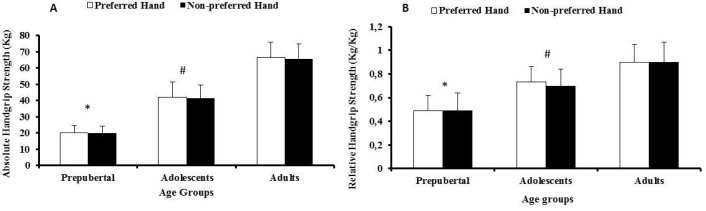
Absolute (A) and relative (B) handgrip strength values (kg; kg / kg BM, respectively) in children, adolescents, and adults basketball players. Values are means ± SD in each hand per age group; *p < 0.05 vs. all other groups; #p < 0.05 vs. adults.